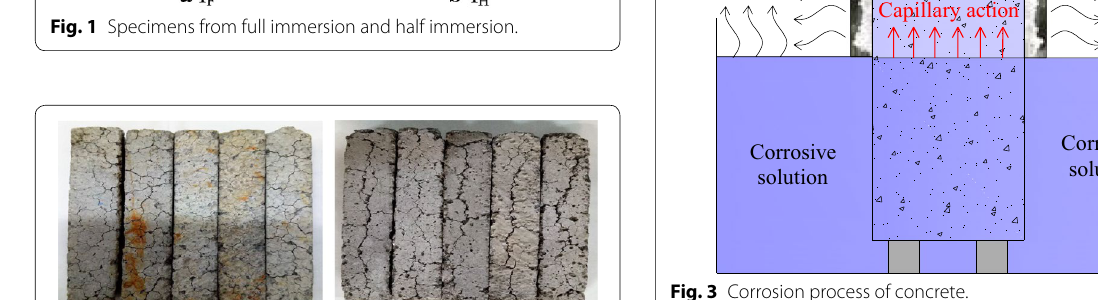
Fig. 3 Corrosion process of concrete.